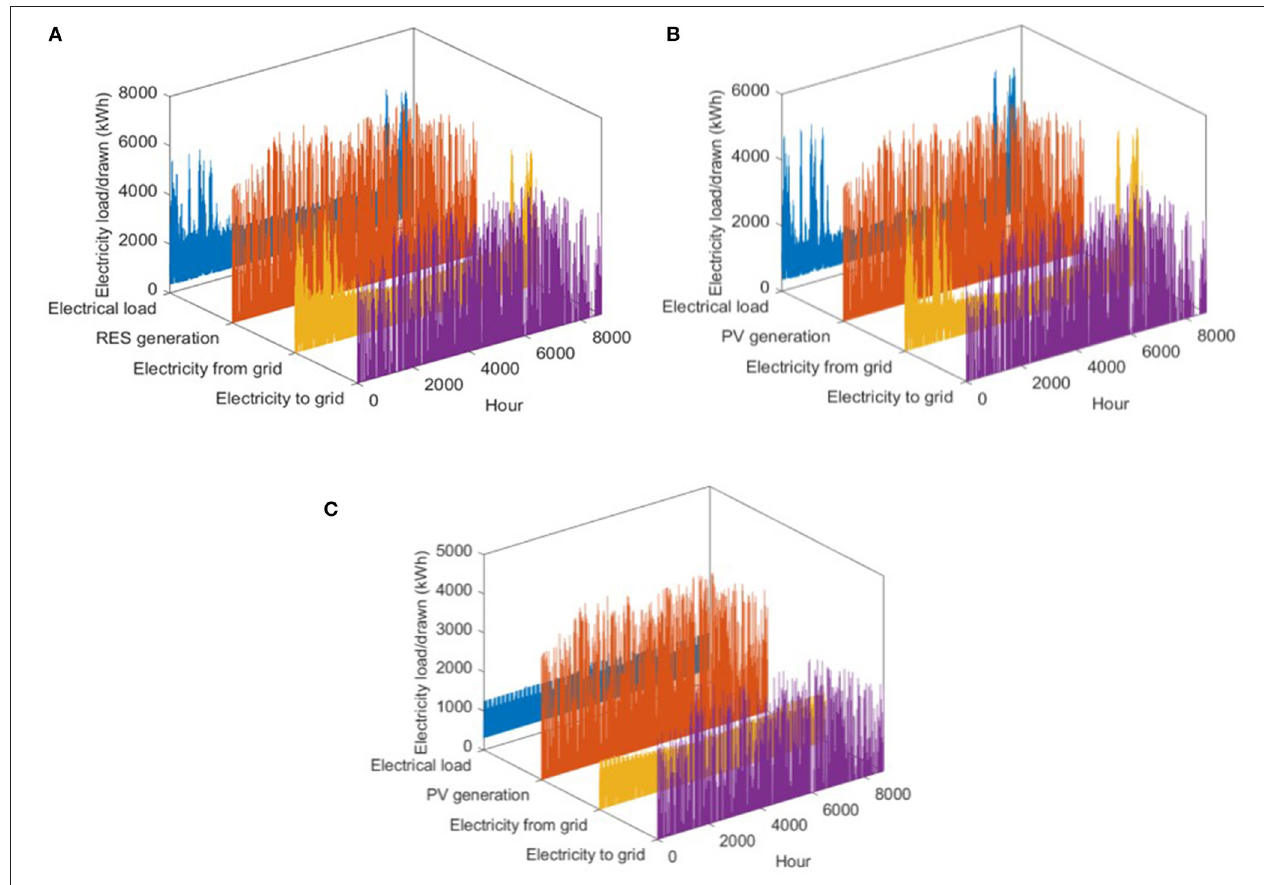
FIGURE 2 | Hourly electrical load, PV generation, electricity sold to grid and bought from grid for (A) SC1, (B) SC2 and (C)